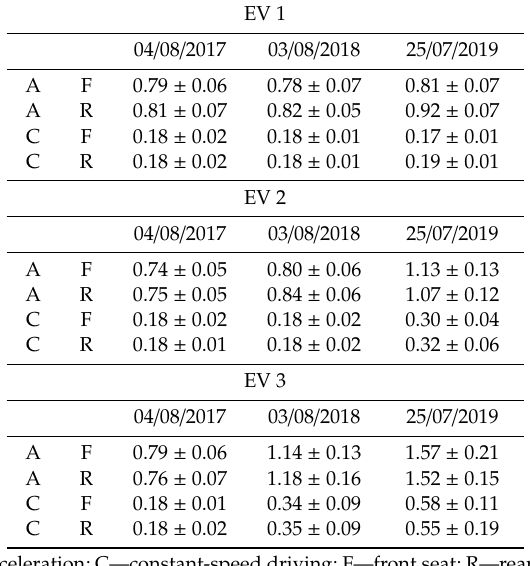
Table 2. Measured broadband B strength. A: acceleration; C: constant-speed driving; F: front seat; R: rear seat. The results are expressed in the form of mean ± standard deviation. Units in µ